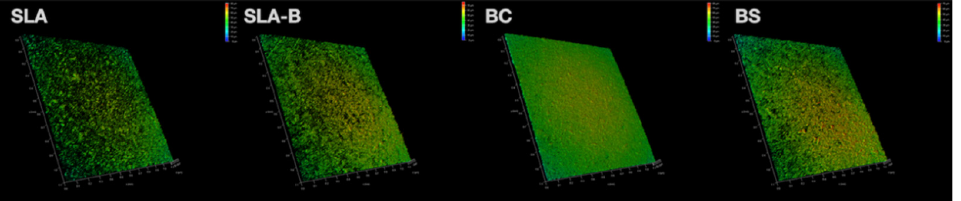
Figure 6. Three-dimensional images obtained by CLSM, illustrating the surface roughness and surface topography of the experimental disks.